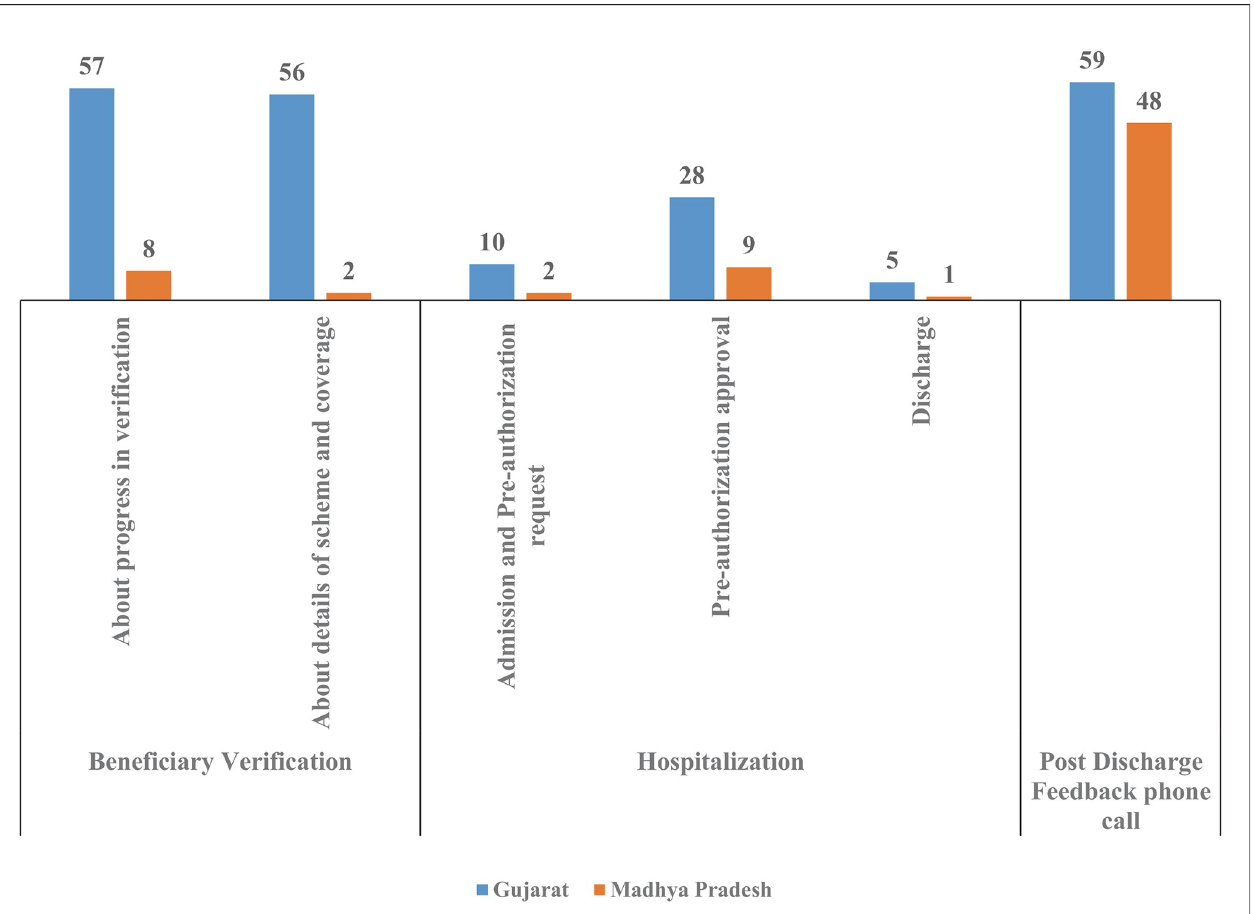
Fig 3. Proportions of beneficiaries who received SMS/call about specific processes (in %).